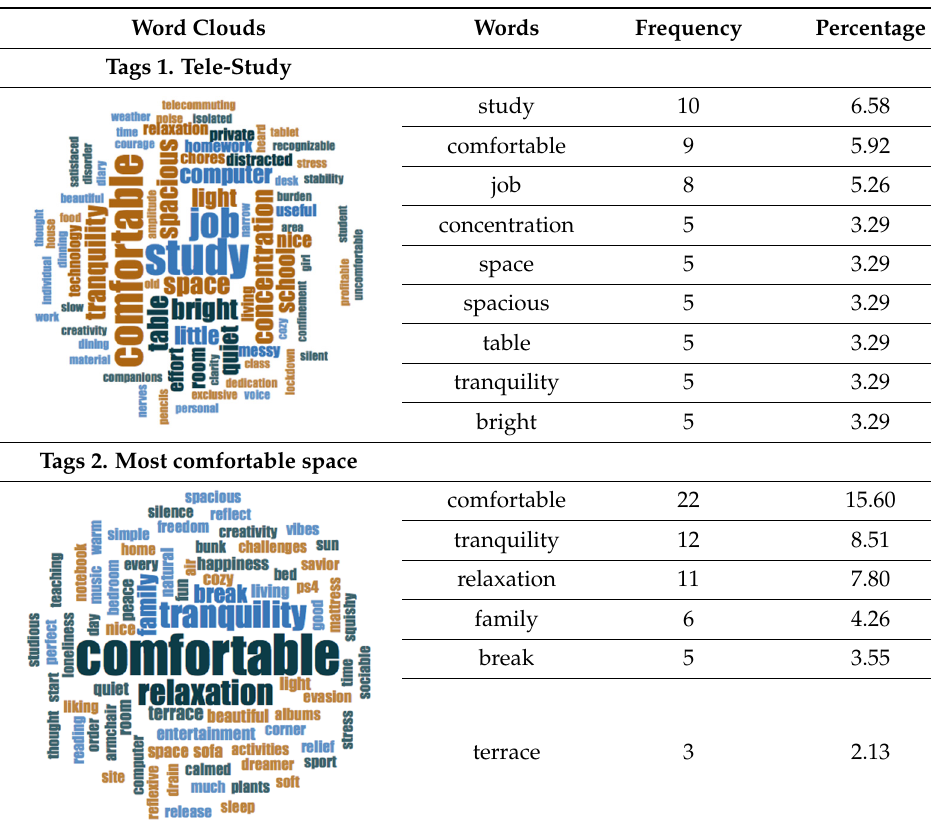
Table 4. Word clouds referred to picture-related questions on tele-study spaces at home. Block 1: Tele-Study. Word Clouds for Related